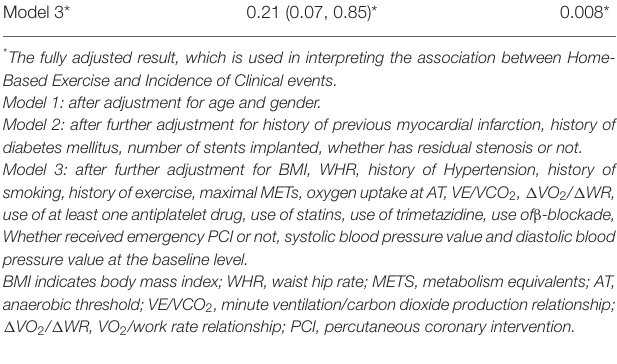
TABLE 3 | Multivariate Cox regression analysis of the correlation between Home-Based Cardiac Rehabilitation program and incidence of clinical events, with and without adjusting for confounding variables.